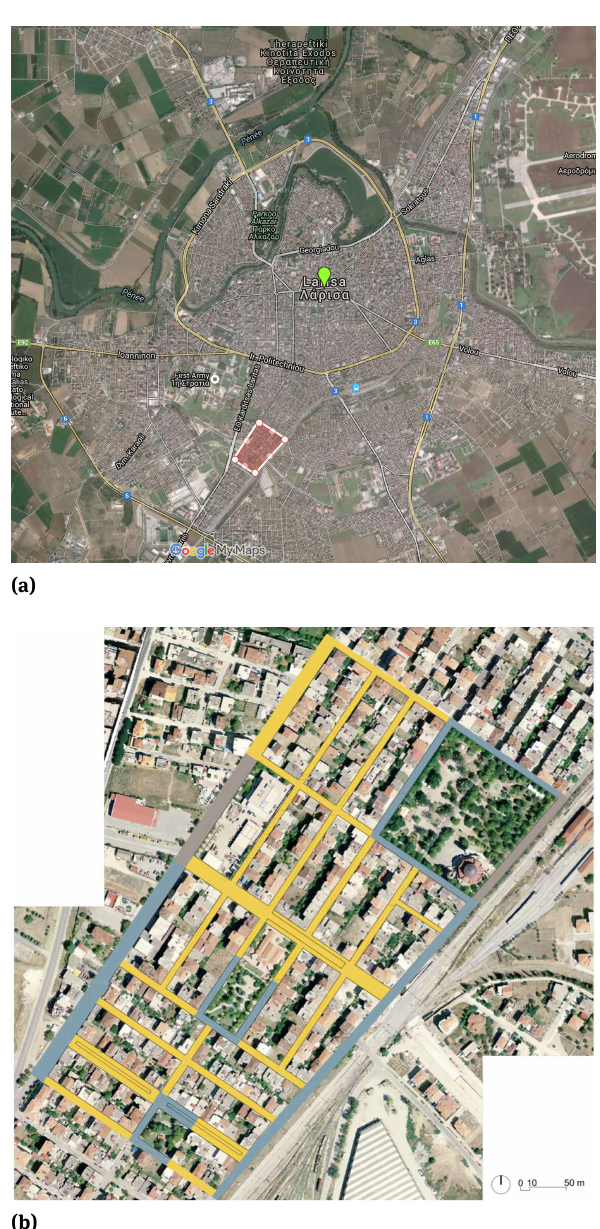
Figure 5: Larissa U.A.: (a) Katechaki District localisation (red hatch) and (b) typology street sections map,